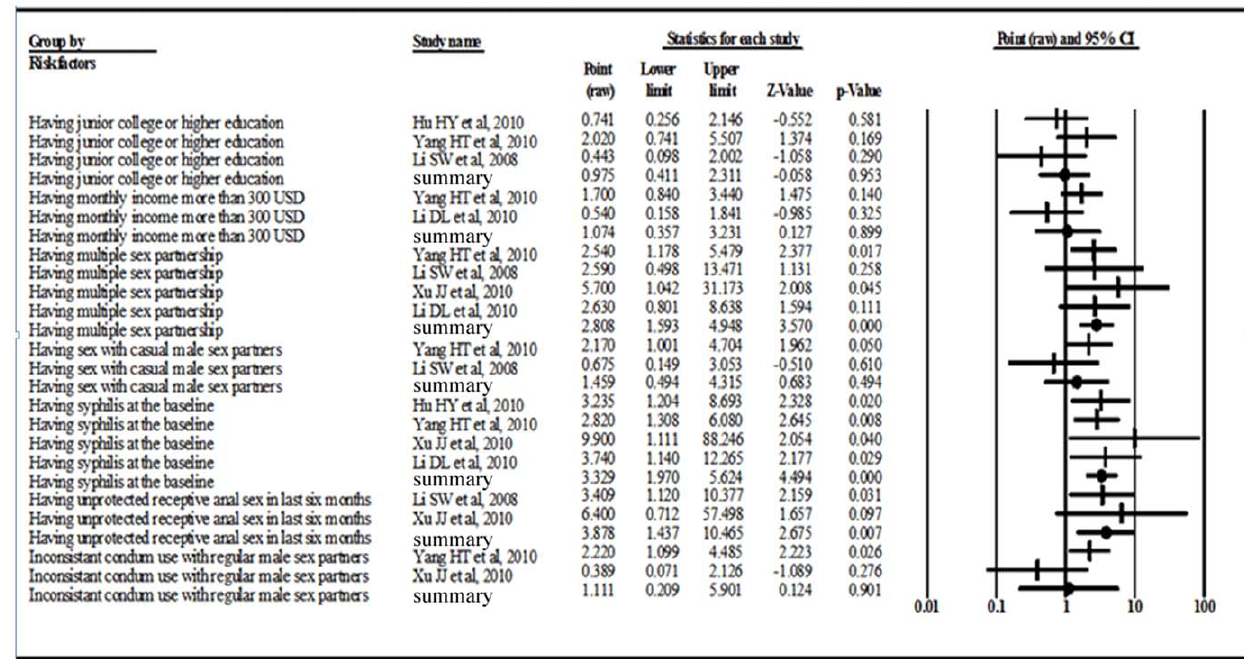
Figure 3. Crude results based on meta-analysis of studies assessing risk factors of HIV incidence.